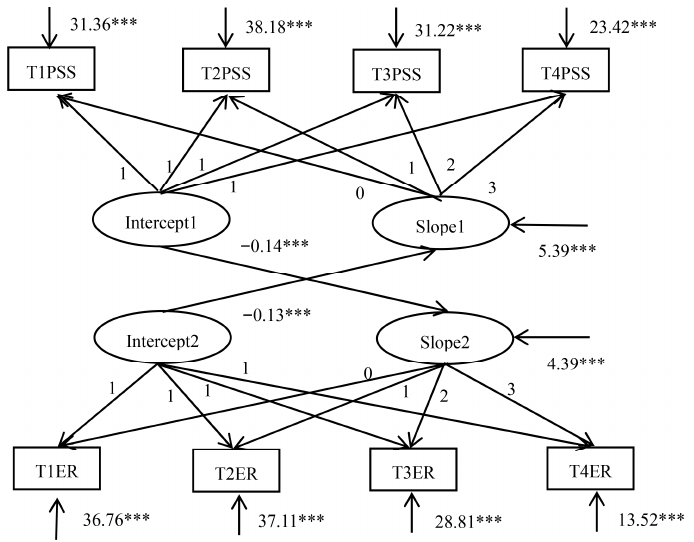
Figure 1. Parallel process latent growth model for ego ‐ resiliency and perceived social support. Notes. PSS = perceived social support, ER = ego ‐ resiliency, *** p < 0.001.